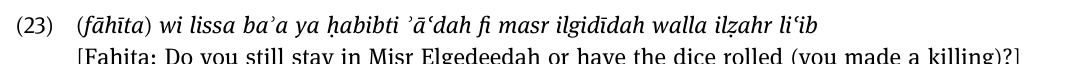
[ Fahita: Do you still stay in Misr Elgedeedah or have the dice rolled ( you made a killing ) ? ] She also asks intrusive questions about personal activities related to hygiene and beauty maintenance. In ( 24 ) , she asks about the amount of time Rania spends in the toilet.